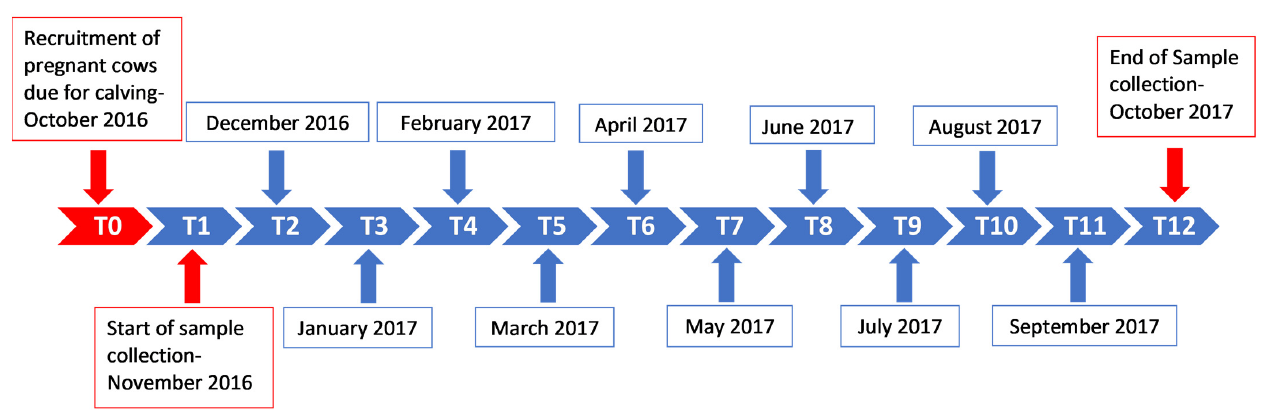
Figure 2. Sample collection timeline for the study. Samples were collected monthly from the ten calves for a period of one year (T1—November 2016, T2—December 2016 and T12—October 2017), from the ages of 0–1 months old (0–1 M) to 11–12 months old (11–12 M). T(x) = time point (month number).